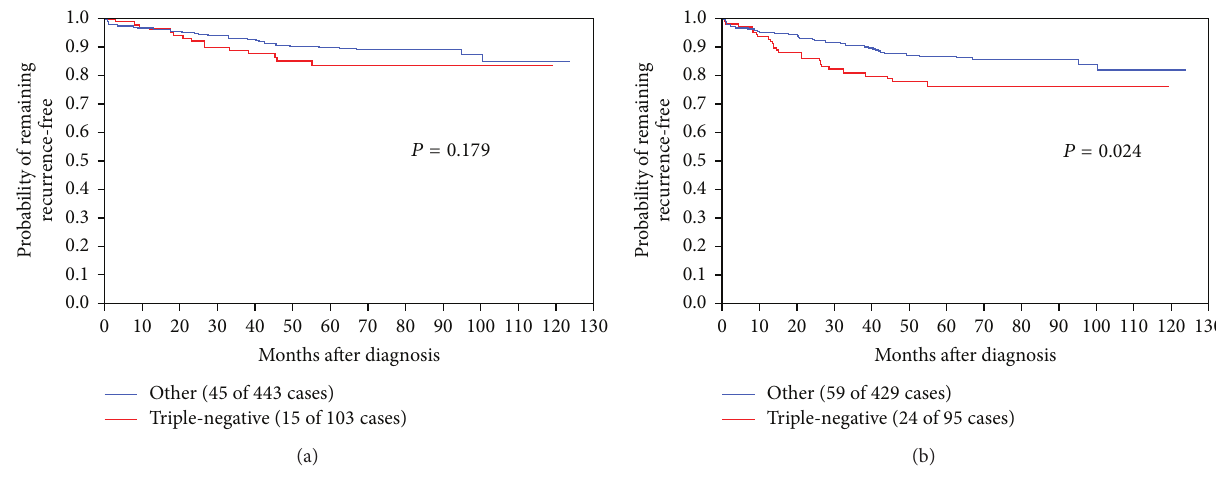
Figure 2: Rate of distant recurrence to bone (a) and to viscera (b) after breast cancer diagnosis in triple-negative women compared with other cancer